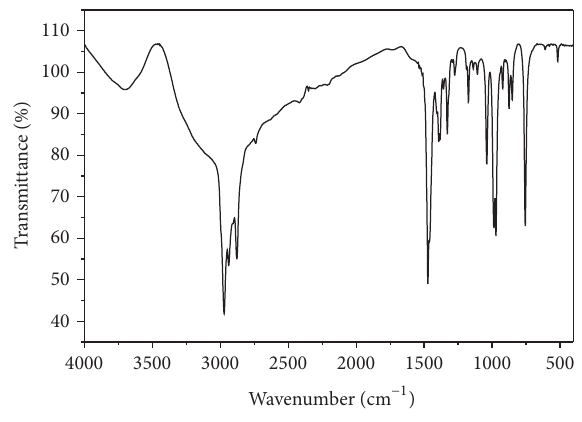
F 4: Infrared spectrum of the [N(C compound